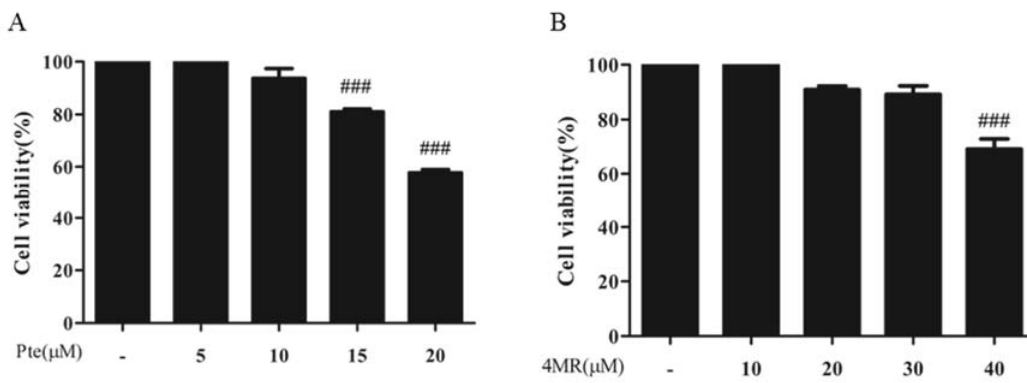
Figure 2. Crystal violet assay showed the effect of ( A ) Pte and ( B ) 4MR on cell viability. Cells were treated with 0–20 μ M of Pte and 0–40 μ M 4MR of for 24 h. The data were representative of the three independent experiments and presented as the mean ± SEM. ### p < 0.001 compared to control. 2.2. Pte and 4MR Inhibited LPS ‐ Induced NO Production By Attenuating iNOS Expression in